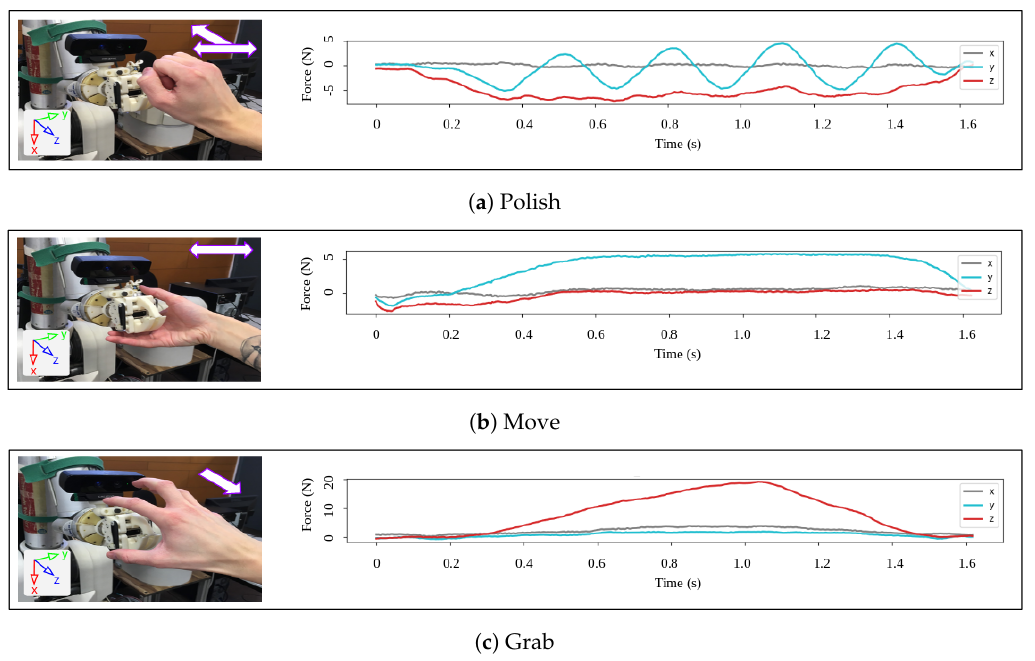
Figure 3. Mechanical dataset. Human movement patterns (left side) and appearance of the force signals produced by those patterns (right side). Observe how each class ( a – c ) is quite distinguishable from the rest even after only 0.4 s. Making use of this dataset to train a model would allow predicting fast with enough confidence. Nevertheless, the movement patterns of the user would be too restricted, and the human–robot interaction would not be natural.